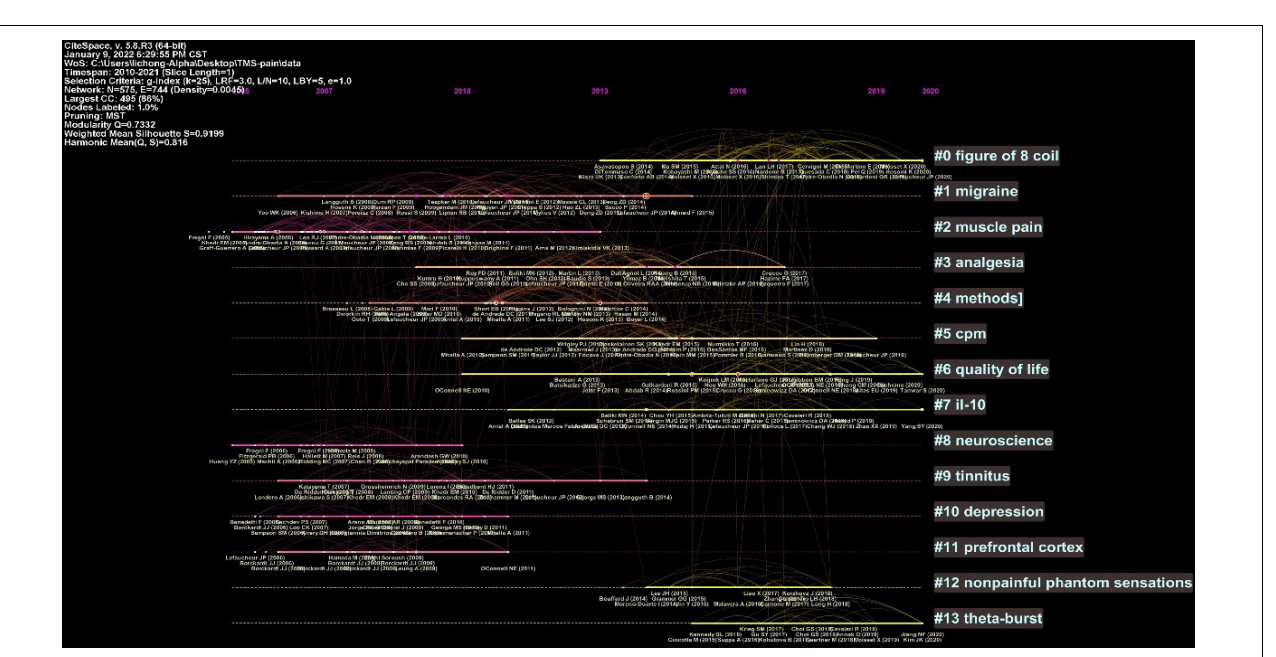
FIGURE 6 | Timeline view of reference co-citation